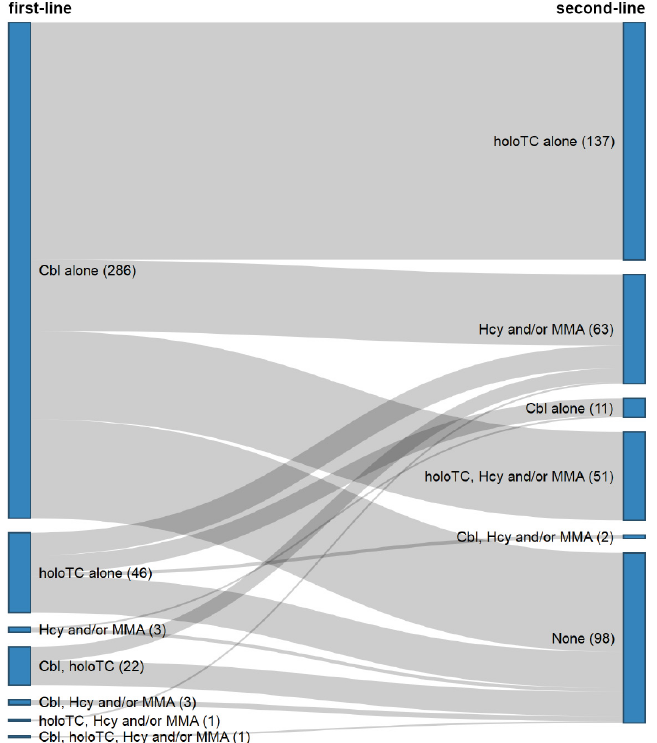
Figure 2. Use of serum laboratory tests for vitamin B12 status assessment. Testing strategies used for first- and second-line assessments are indicated in the left- and right-hand columns of the Sankey diagram, respectively (corresponding number of respondents in parentheses). Abbreviations: Cbl,